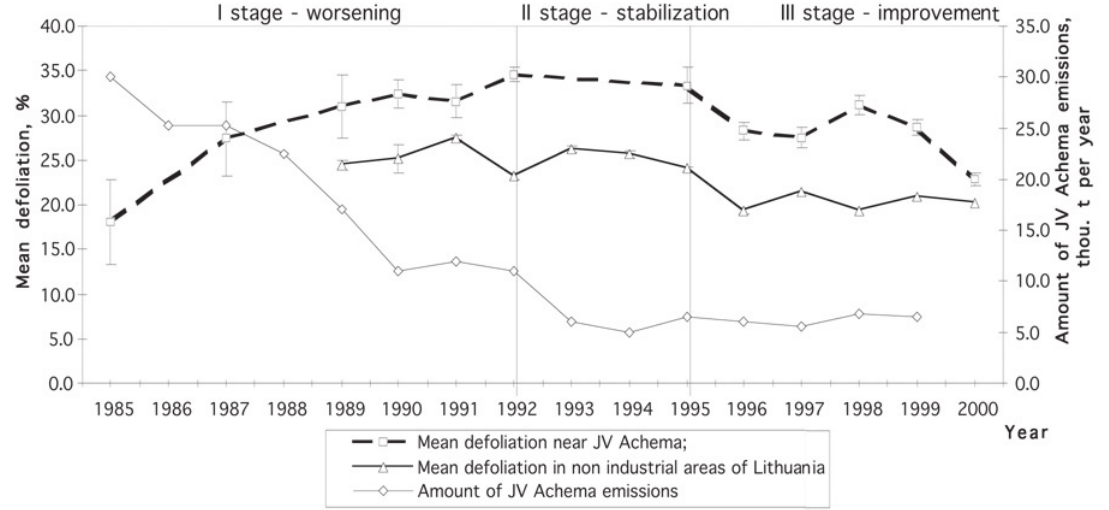
Distance from Plant